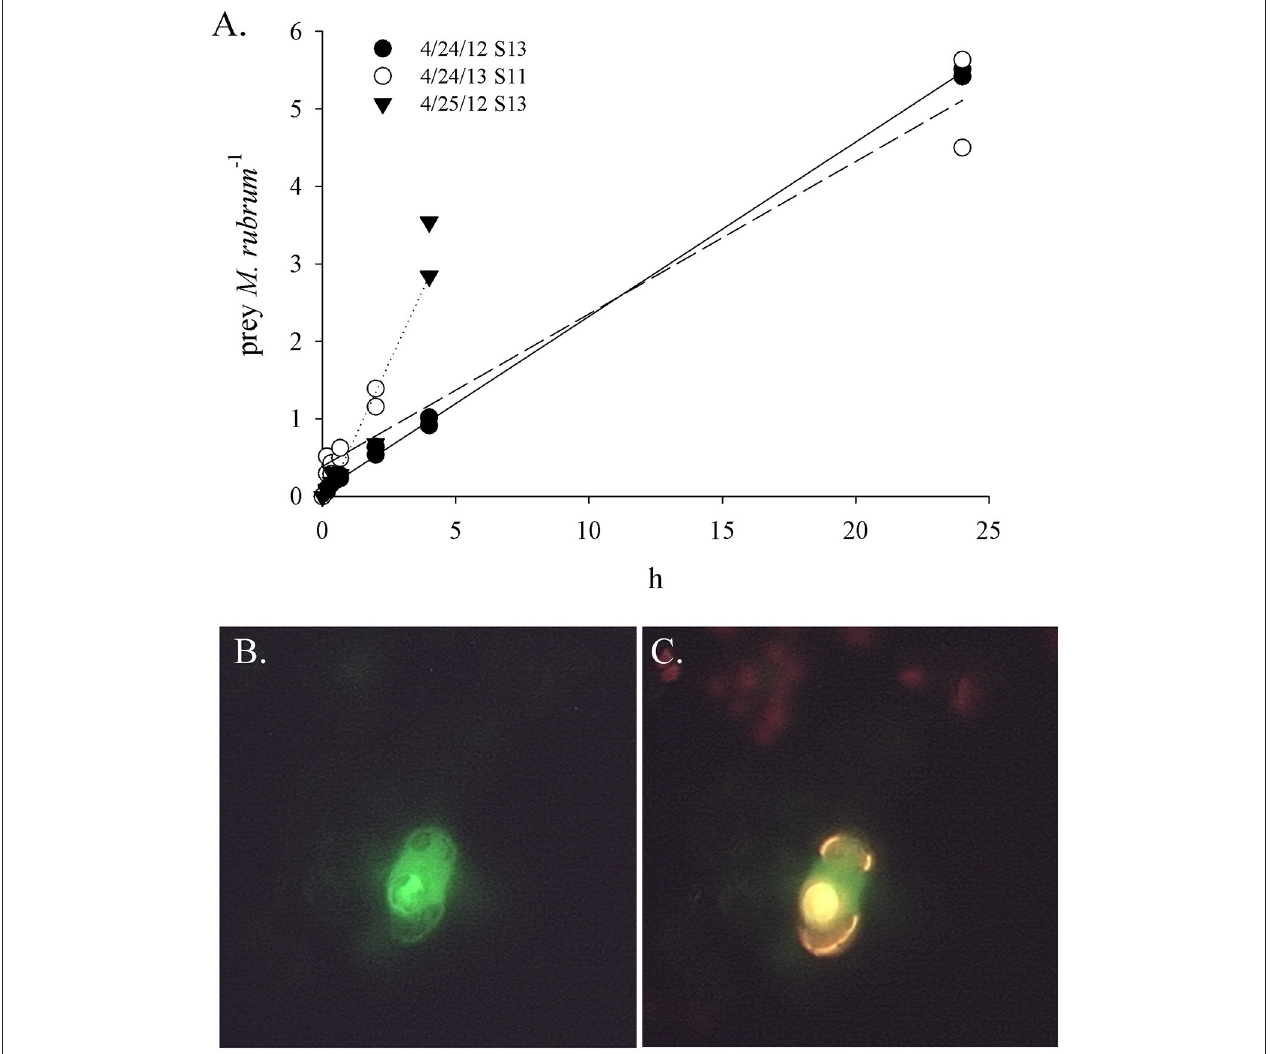
FIGURE 3 | Ingestion of fluorescently labeled cryptophytes (FLC) by Mesodinium rubrum in the Choptank River. (A) Examples of ingested FL Teleaulax amphioxeia over time. Regression equations for each experiment are as follows: 4/24/12 station 13, y = 0.225x + 0.072, R 2 = 0.999; 4/24/12 station 11, y = 0.567x + 0.160, R 2 = 0.908; 4/25/12 station 13, y = 0.748x + 0.156, R 2 = 0.888; (B) An M. rubrum cell with an ingested FL Rhodomonas salina under green emission (BP 515–565nm); (C) Same M. rubrum cell as in (B) with an ingested FL R. salina under a dichromatic long pass emission ( >